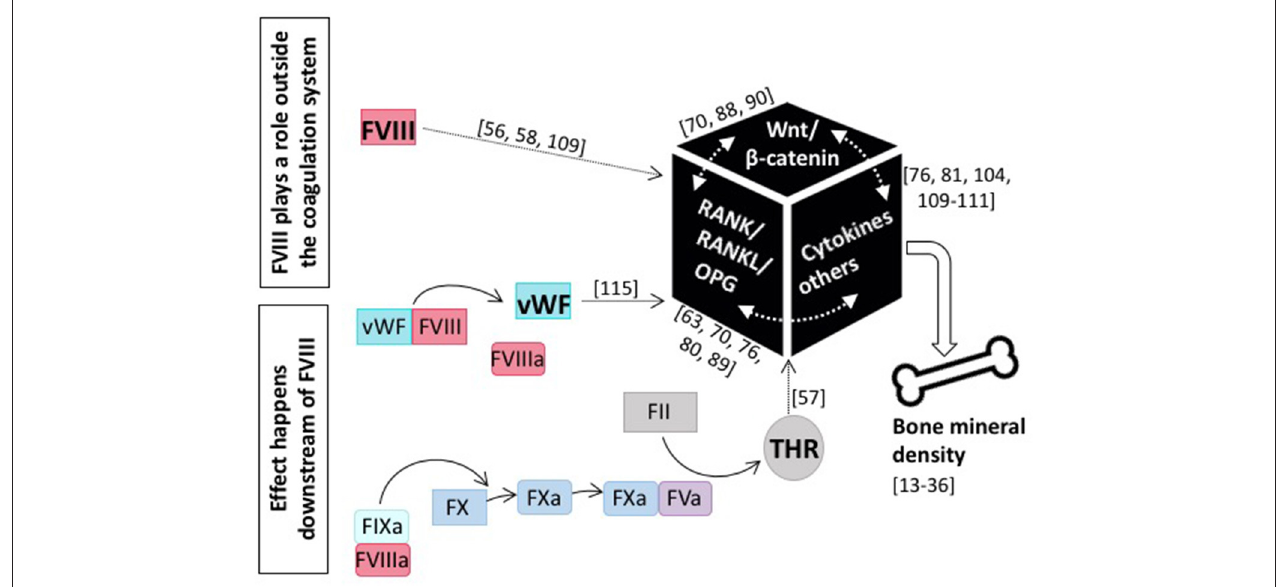
FIGURE 3 | The role of coagulation FVIII in bone health. Current knowledge tells us that several modes of action for FVIII impacting bone mineral density are feasible: either FVIII plays a role outside the coagulation system and directly interacts with main players of bone physiology, including the RANK/RANKL/OPG axis and/or the Wnt/ β -catenin pathway, as well as pro-inflammatory cytokines, or the effect happens downstream of FVIII and e.g., the missing interaction with vWF or decreased thrombin production is causative. References for original publications and further reading are written in